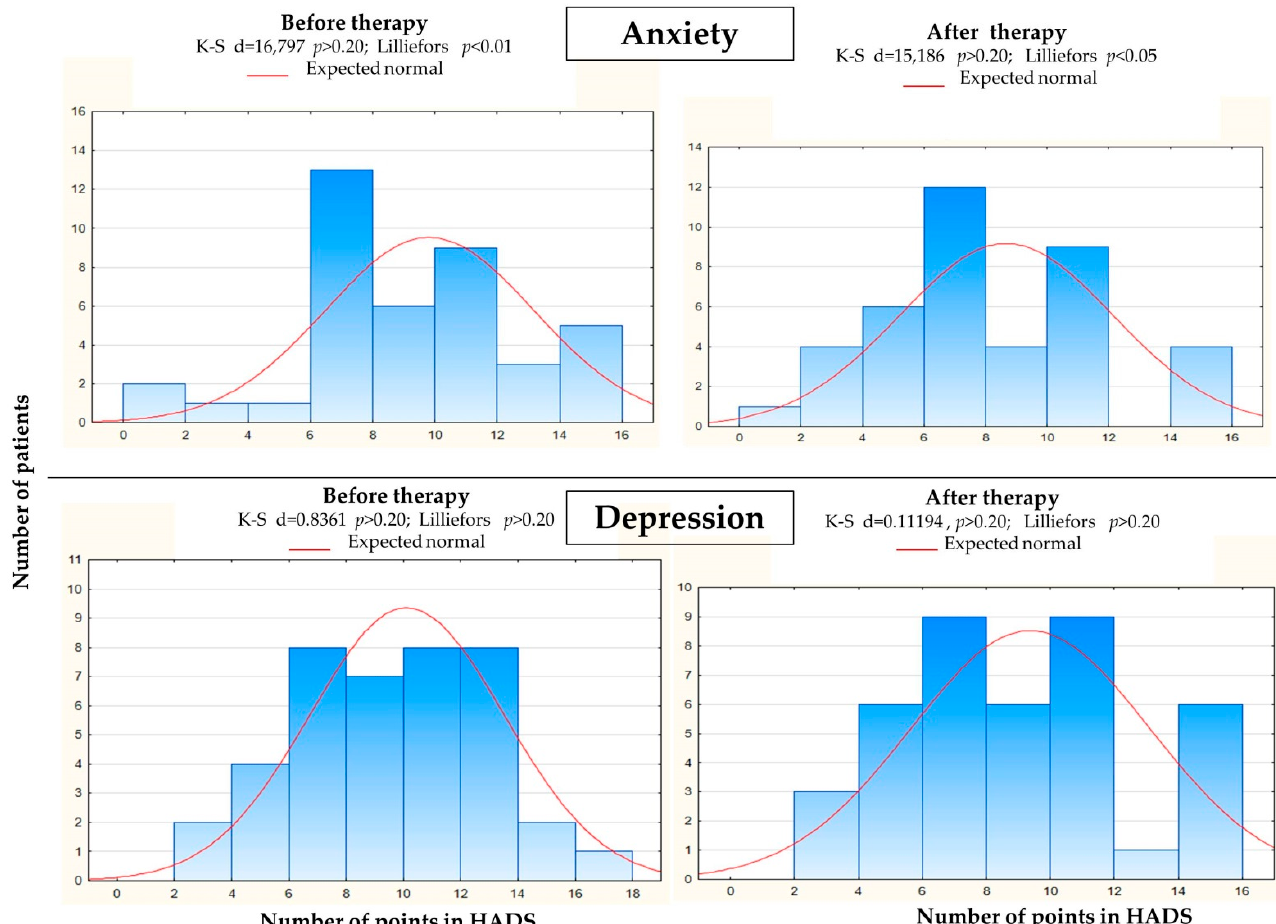
Figure 3. Histogram of HADS points in anxiety and depression disorders in measured group before and after therapy .